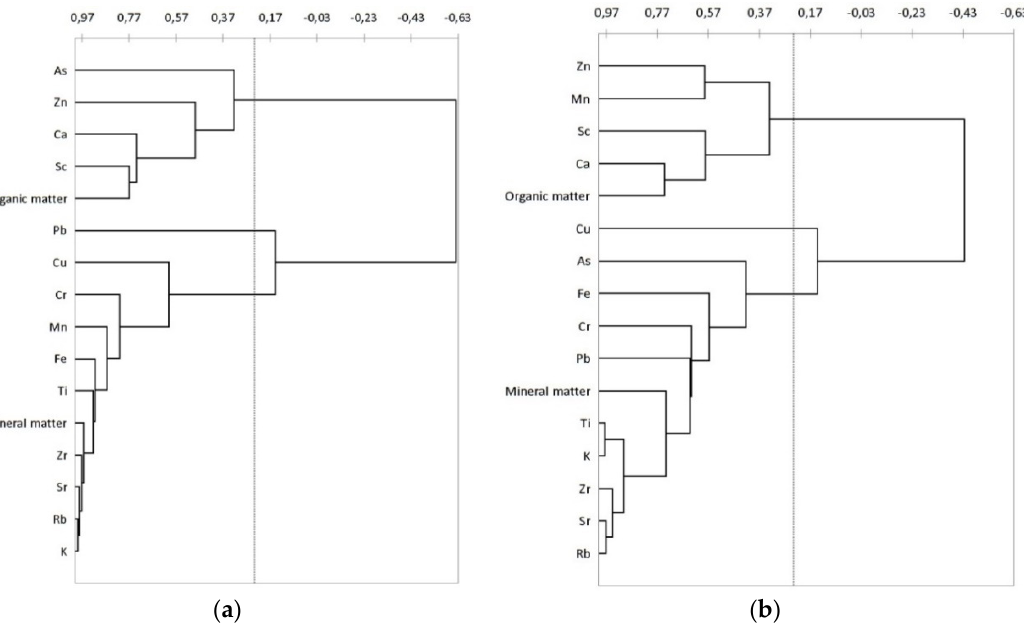
Figure 11. Cluster analysis (Spearmann correlation matrix, p < 0.05) of data from Lakes Salot˙e ( a ) and Gineitišk˙es ( b